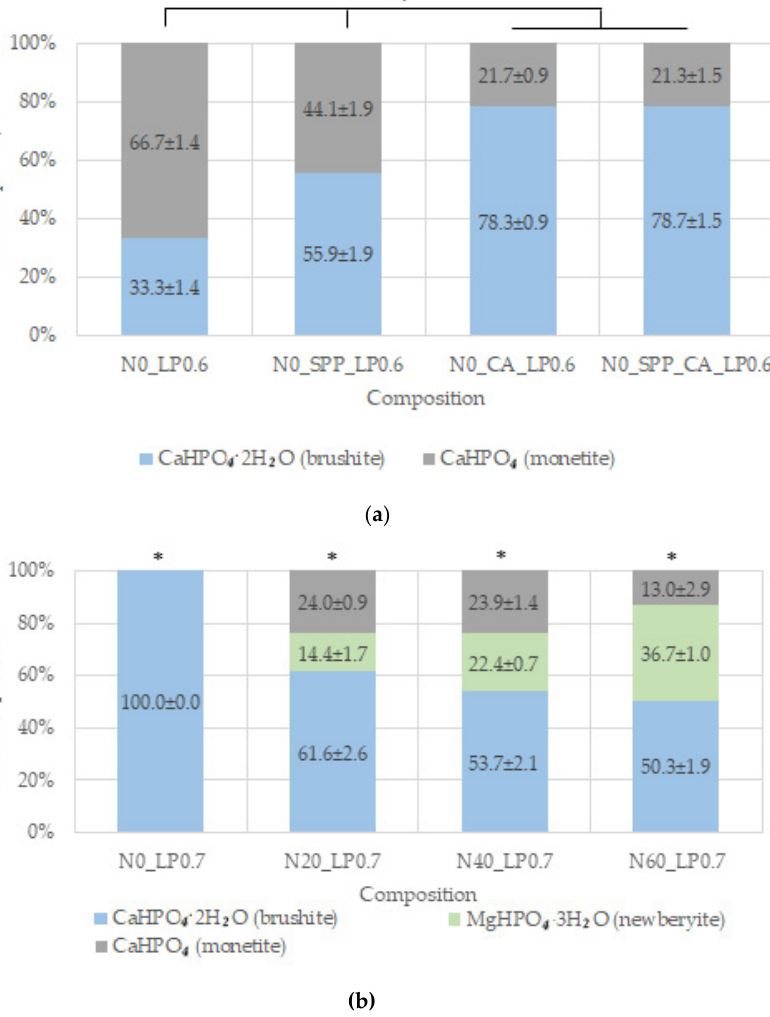
( b ) Figure 10. Cytotoxic effect of ceramics after 24 ( a ) and 96 h ( b ) of cultivating mesenchymal stromal cells of human bone marrow on them. 93